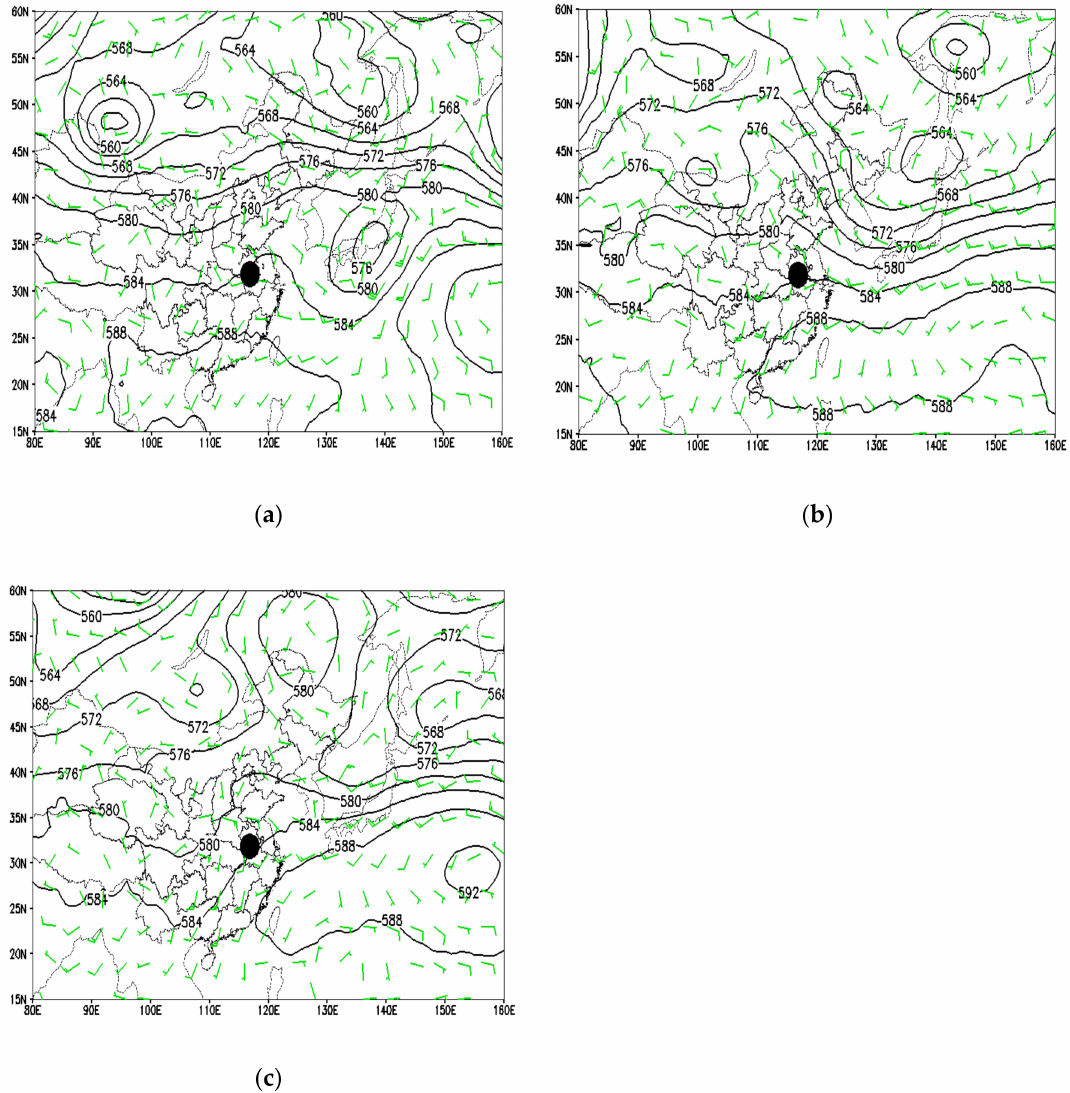
Figure 2. Geopotential height at 500 hPa and horizontal wind barbs at 850 hPa (the location of the black spot is the study area). ( a ) 1400 LST 22 June; ( b ) 0200 LST 28 June; ( c ) 1400 LST 11